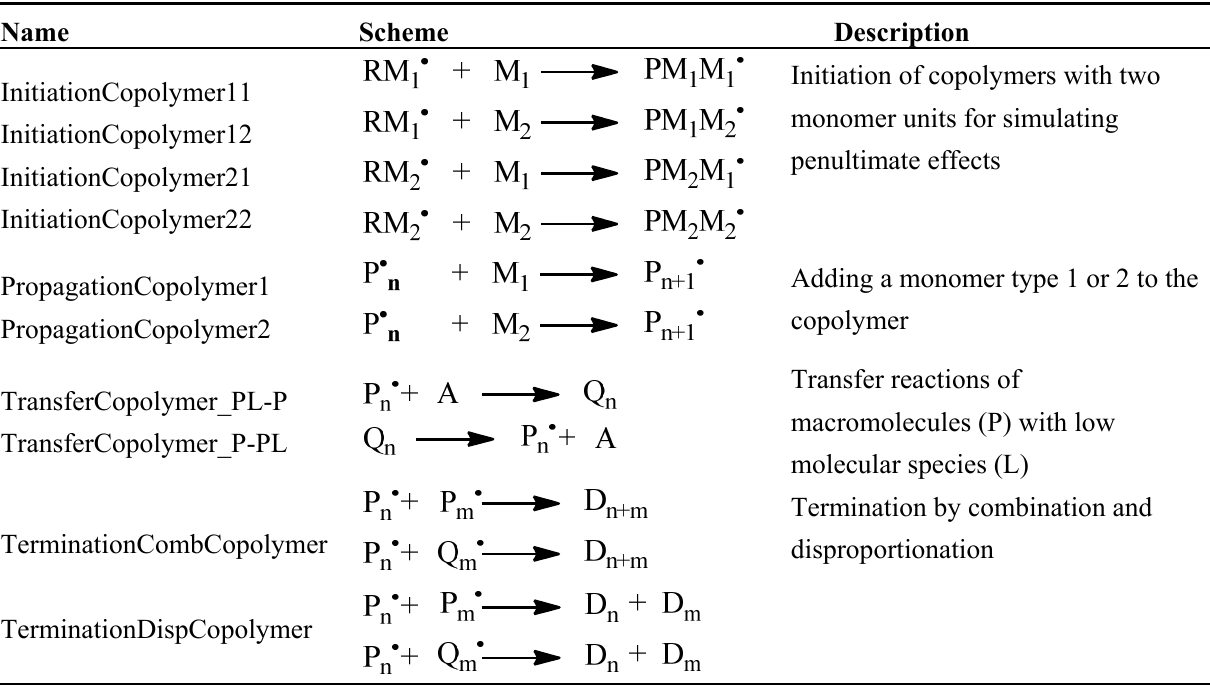
Table 3. Reaction templates for copolymerization